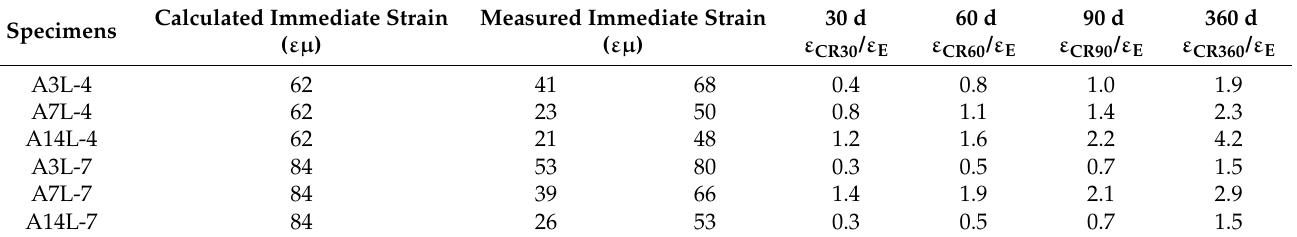
Table 4. Creep strains of various specimens based on the test and the proposed formula at different times.